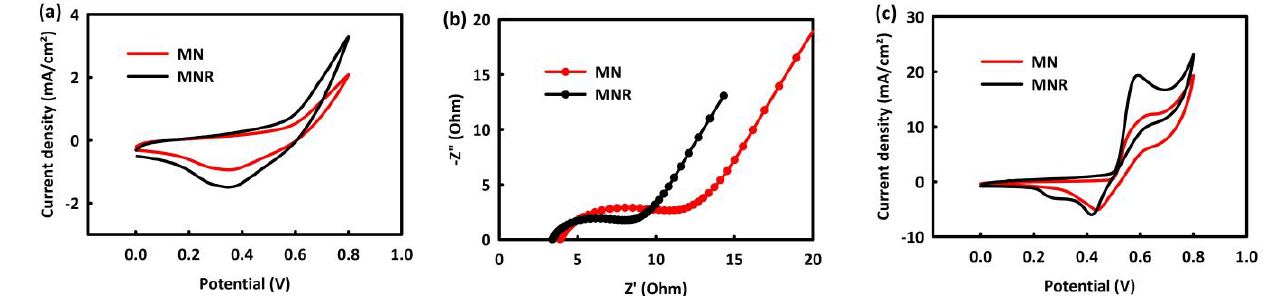
Figure 4. CV curves of MN and MNR ( a ), EIS plots of MN and MNR in 2M KOH ( b ), and CV curves of the MN and MNR 2 M KOH and in the presence of 0.5 M methanol ( c ).